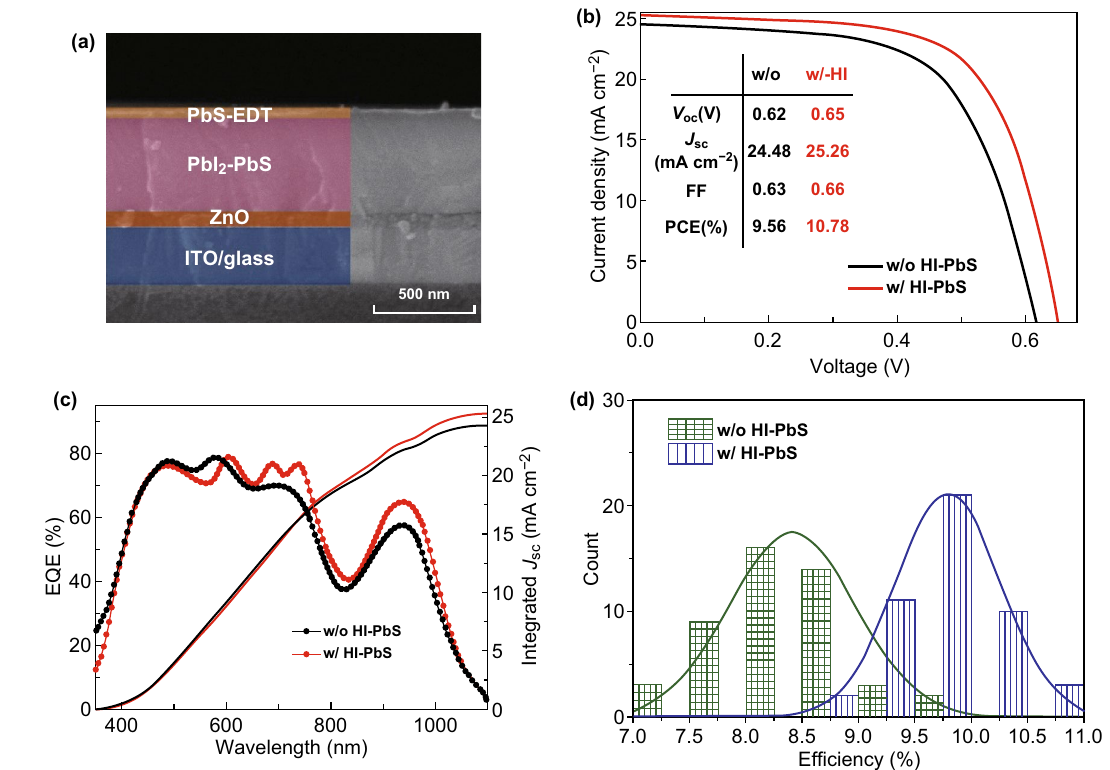
Fig. 5 Device architecture and performances. a The PbS‑QDs solar cell device structure. b Representative J – V characteristics of w/o and w/HI devices under simulated AM 1.5G illumination (100 mW cm −2 ). c EQE spectra and integrated J sc of w/and w/o HI devices. d Statistic histograms of PCE for above two kinds of